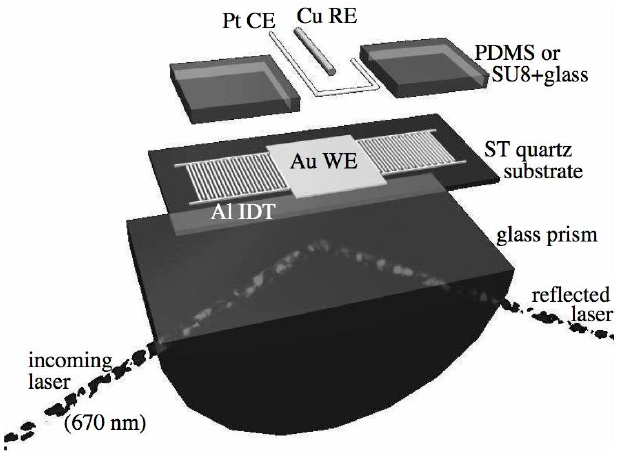
Figure 12. Integrated surface plasmon resonance (SPR) and surface acoustic waves (SAW) device